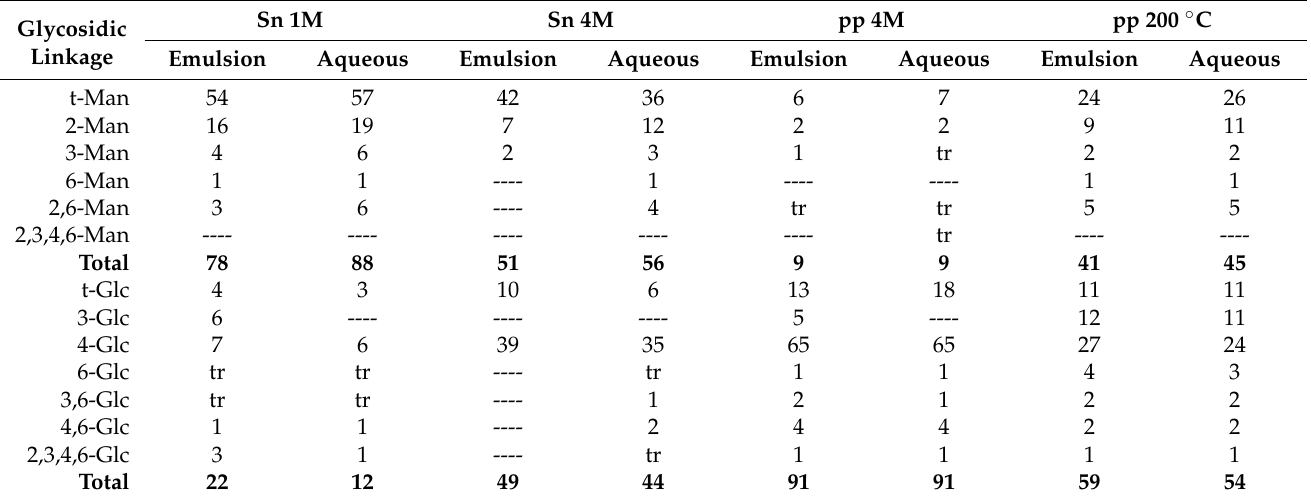
(Table 5) promoted the presence of short chain mannans seen by the increasing amount of t-Man (5 to 18 mol%) and the presence of ( β 1 → 3)-glucans, linkages absent in the aqueous phase. These results suggest the ability of ( β 1 → 3)-glucans to be dispersed in the continuous phase, which may increase the density of the aqueous phase to values near to the density of the droplets, an important characteristic to the emulsion stability. Table 4. Glycosidic linkage composition (molar %) of brewer’s spent yeast extract’s emulsions (hand-shaken) from the material partitioned after phase separation, 1-month storage.